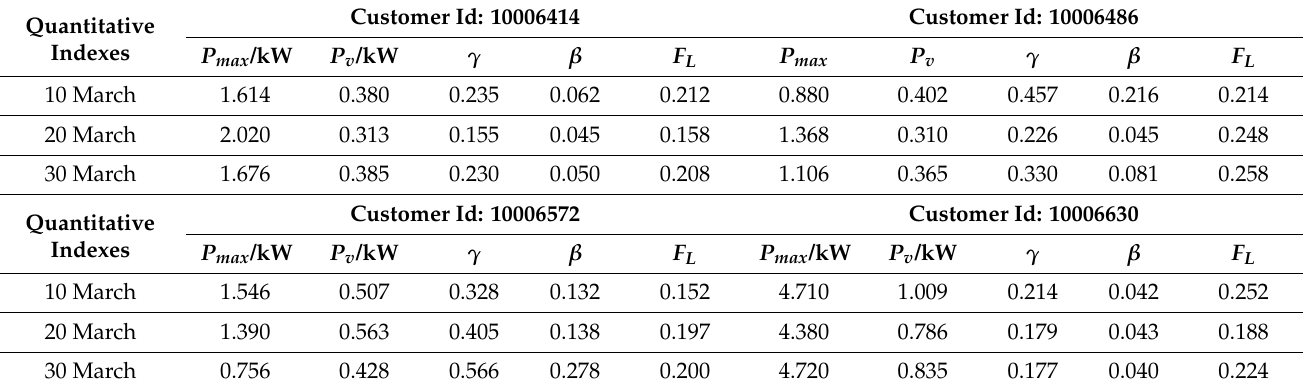
Figure 2. The maximum daily loads of the selected ten customers in March 2013. The mean daily loads and the daily volatility indicators of these ten selected units are also analyzed, and some quantitative indicators are given in Table 1 for intuitive and clear comparison. Table 1. Quantitative indexes of electric loads of selected